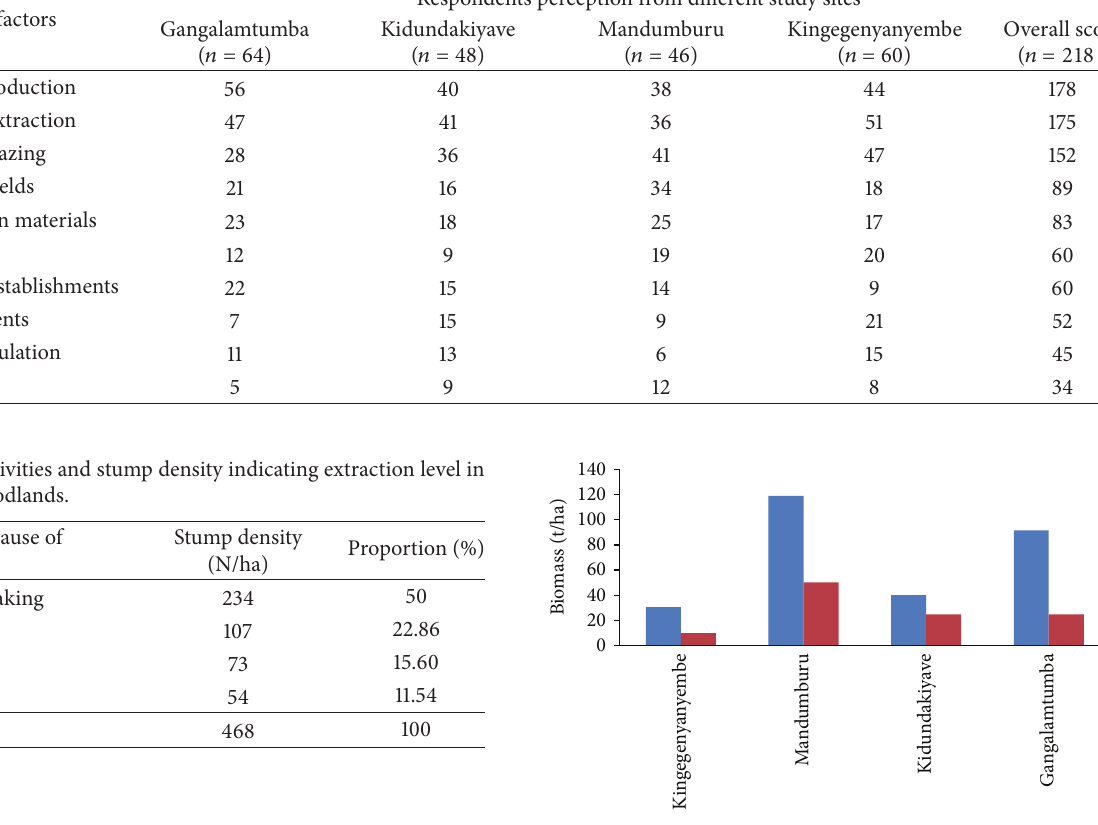
Table 8: Factors for land use and miombo woodlands cover change as perceived by local communities. Underlying factors